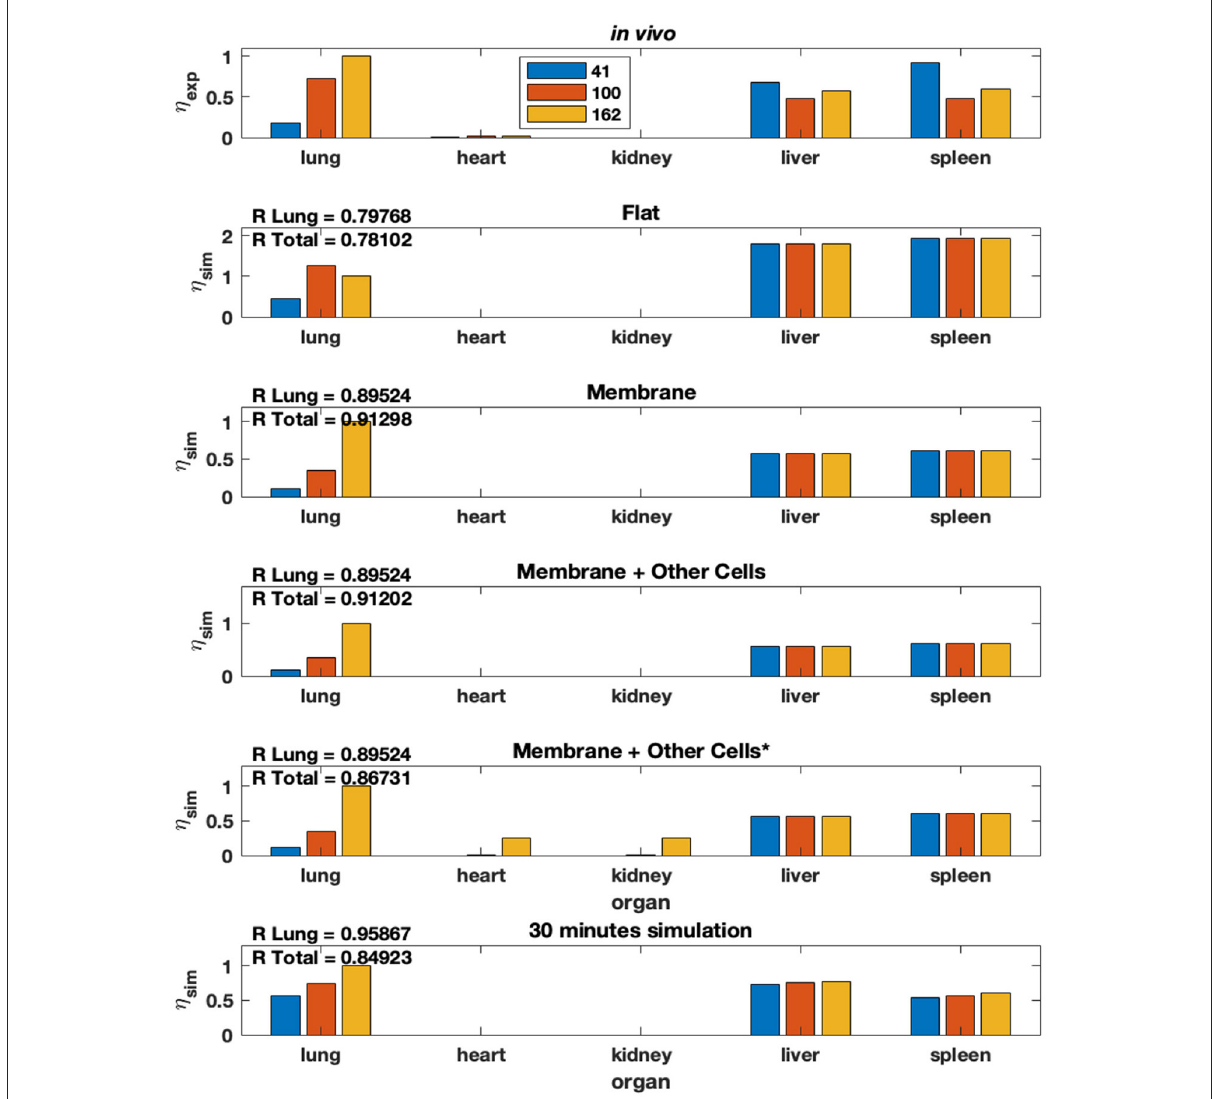
Spleen, we observed similar trends between experimental data and simulation